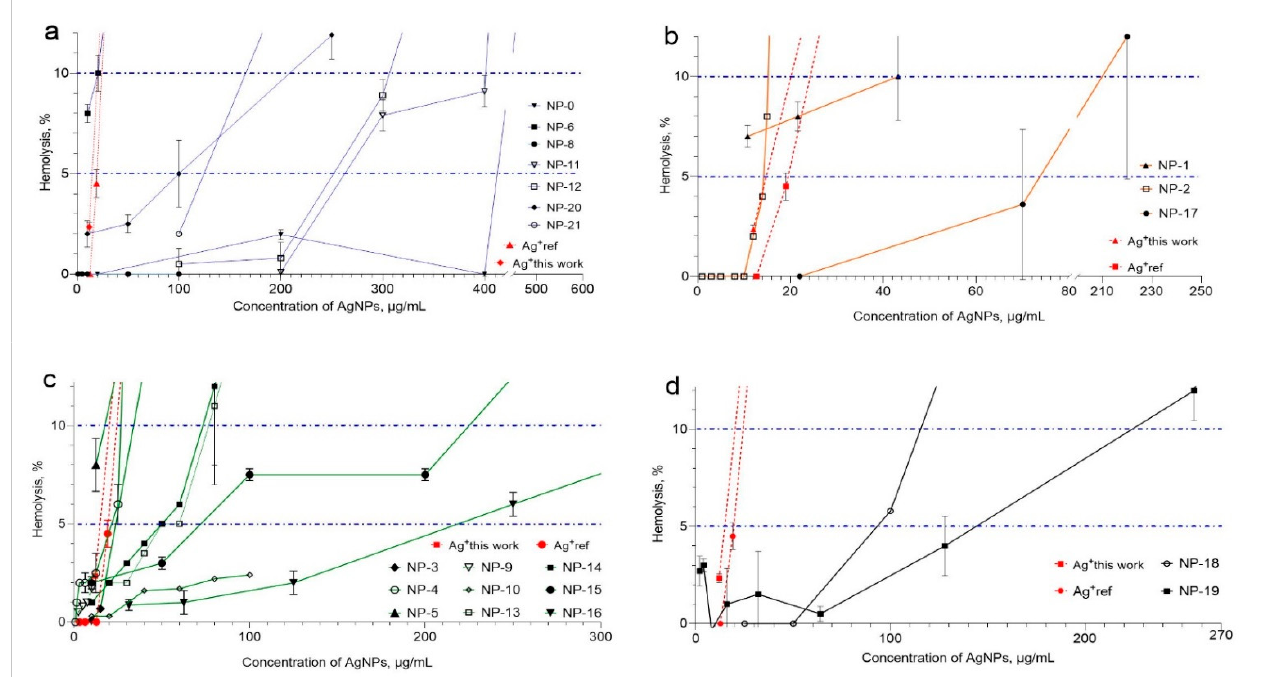
Figure 3. Hemolysis produced by different AgNPs formulations in HDE. AgNP formulations were grouped as follows, considering the coating agents: ( a ) PVP, ( b ) citrate, ( c ) biogenic coating, and ( d ) starch. Label for each AgNPs formulation correspond to label employed in Table S2. For comparative purposes, the limits of no hemolysis (5%) and low hemolysis (10%) are shown with dotted blue horizontal lines.